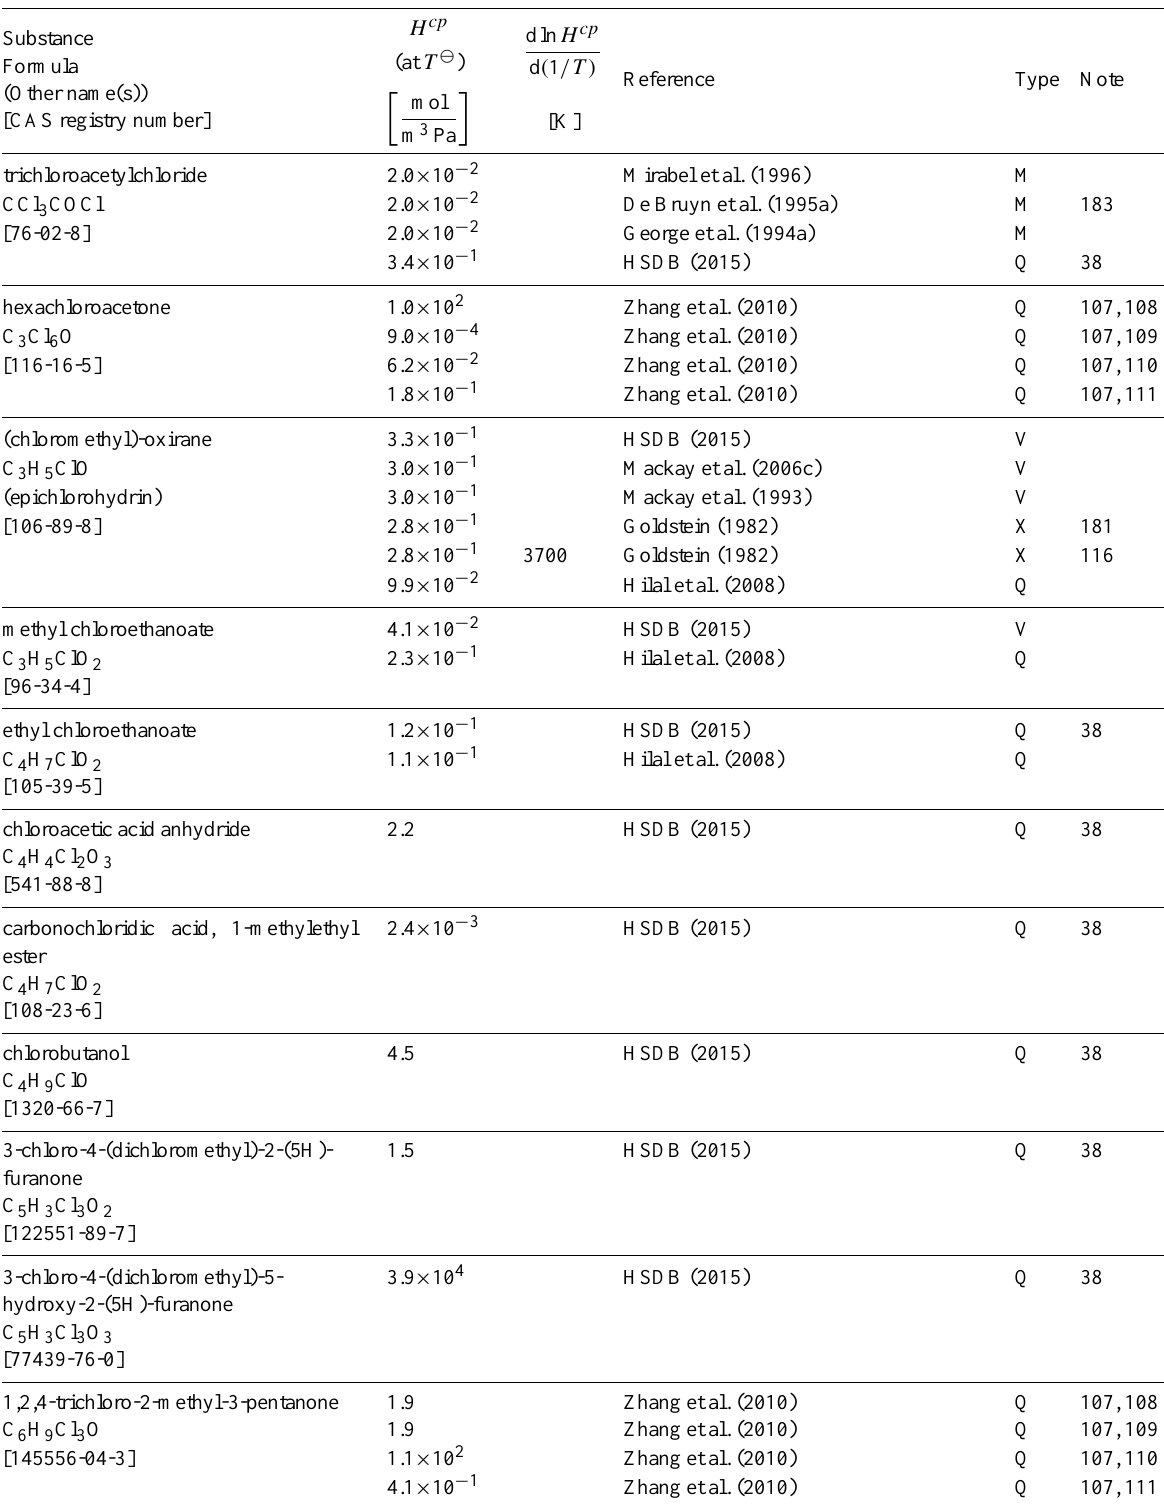
Table 6: Henry’s law constants for water as solvent